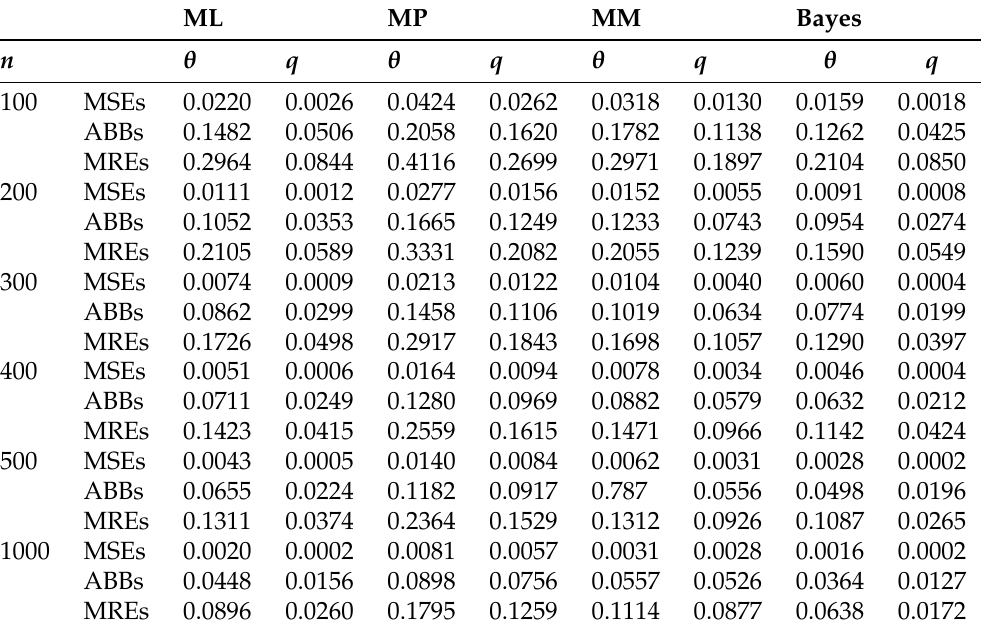
Table 4. Simulation results of the TRTG model for θ = 0.6 and q =